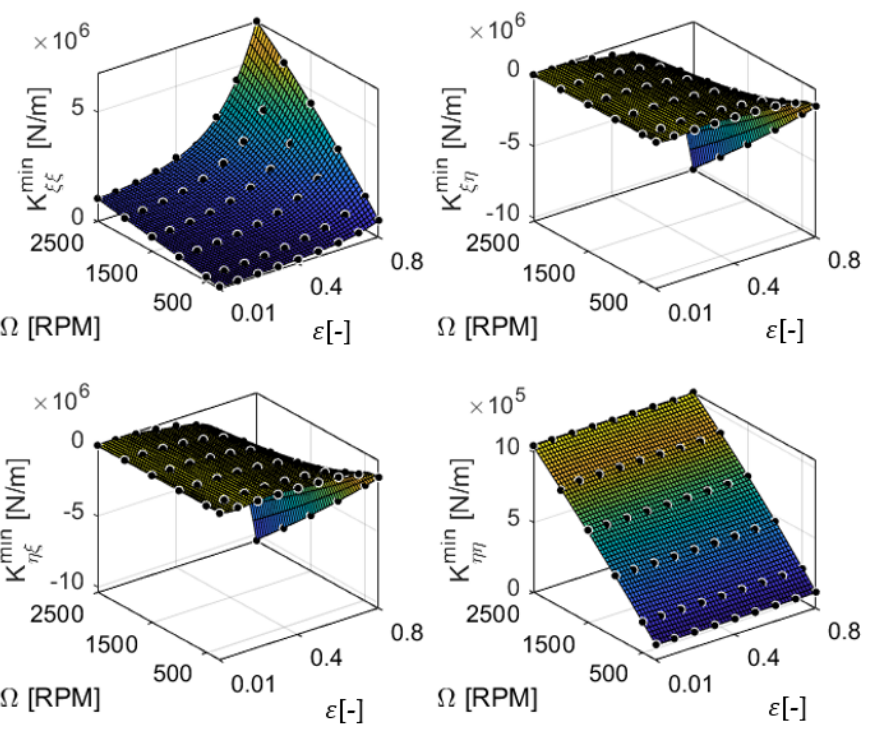
Figure 9. The minimum stiffness coefficients in the local coordinates, fitted using MATLAB ( poly53 ). The dots represent the results from the fluid film simulations.